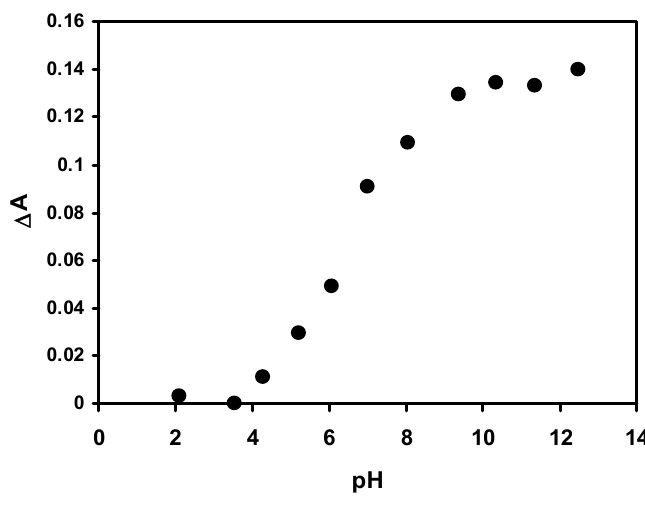
Figure 2. The response of the Nile Blue chromoionophore towards the changes of pH measured at 550